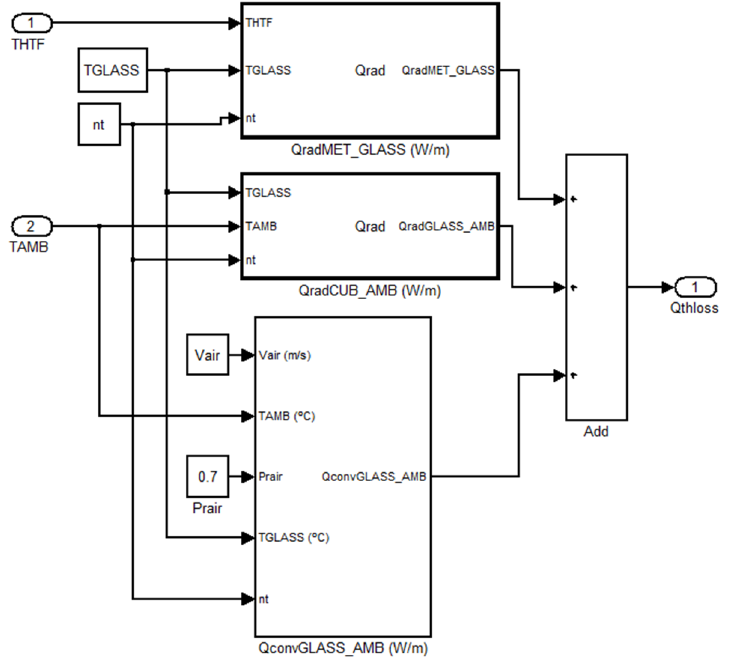
Figure 13. Thermal losses blocks.